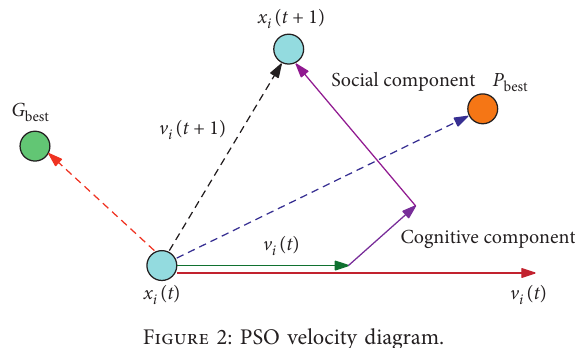
Figure 2: PSO velocity